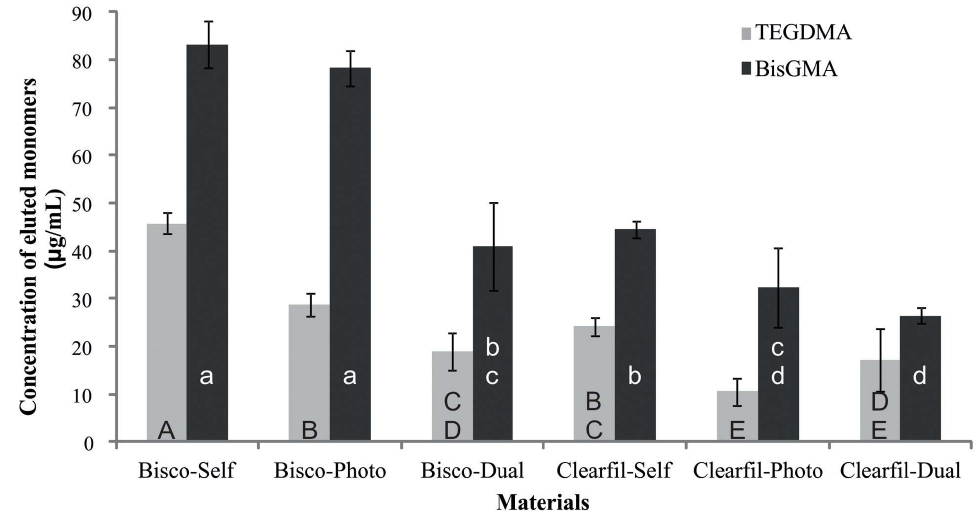
Figure 4. Mean and standard deviation values of monomer elution from core materials. The same upper-case letters indicate no significant differences in TEGDMA elution; the same lower case letters indicate no significant differences in BisGMA elution ( p > 0.05).